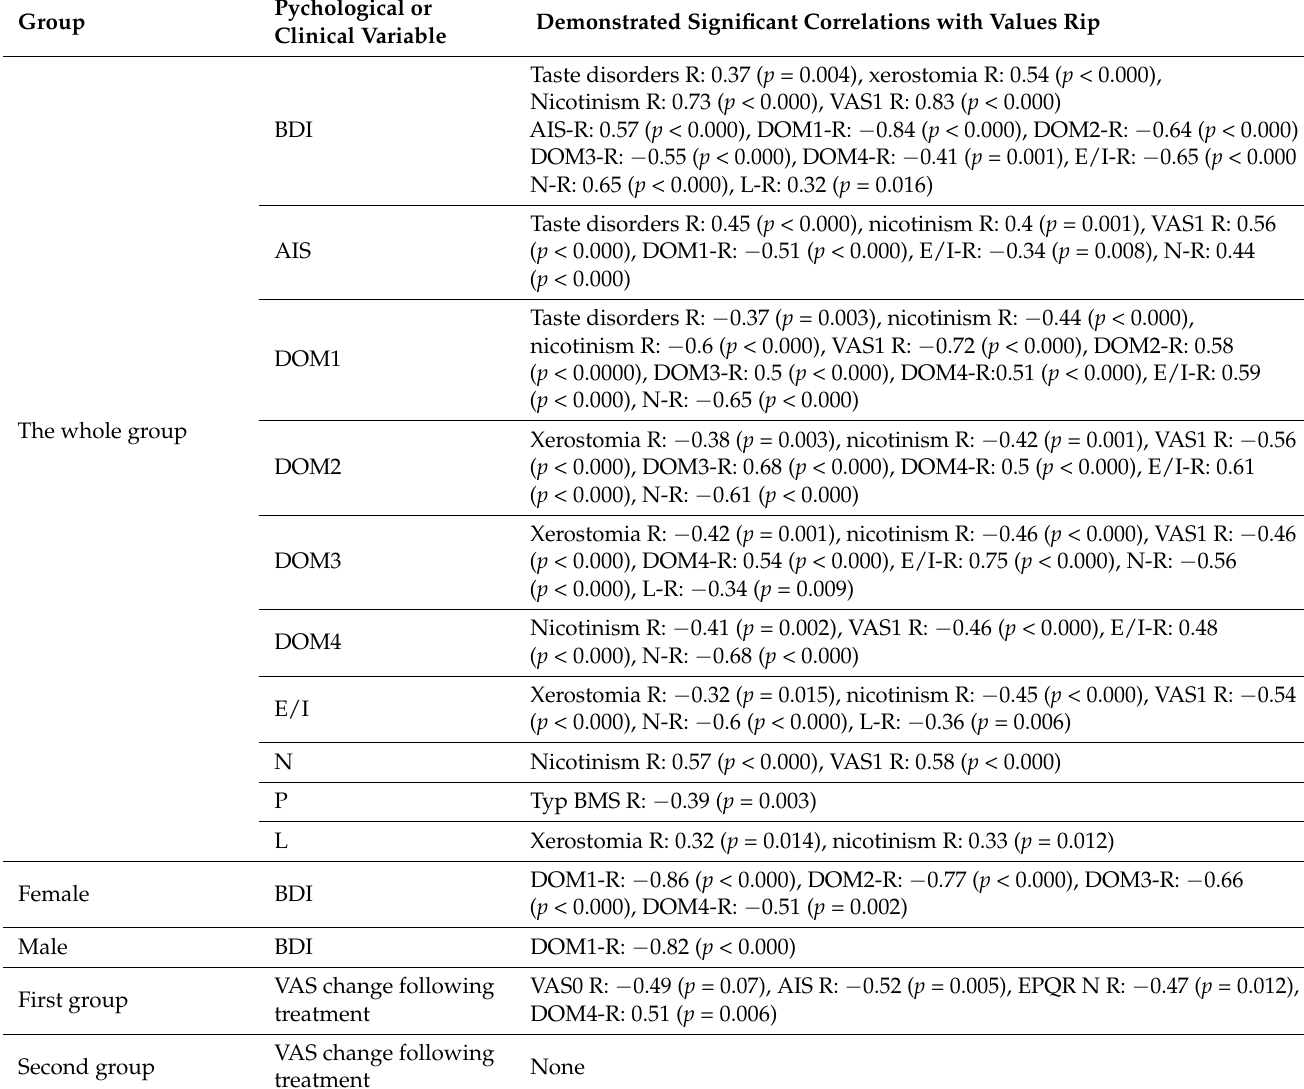
Table 4. Correlations of psychological and clinical